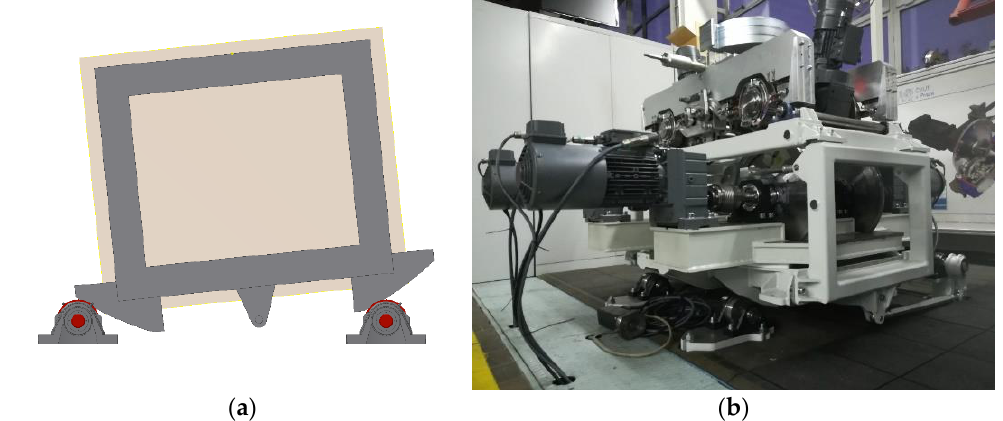
Figure 14. Principle ( a ) and design solution ( b ) of the roller rig tilting.